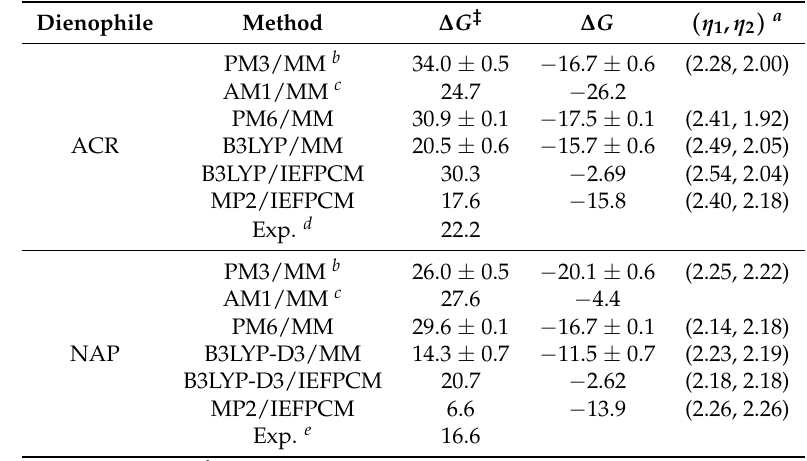
Figure 3. The free energy surfaces under the PM6/MM Hamiltonian ( left ) and under the B3LYP/MM Hamiltonian after Gaussian process regression ( right ) for Diels–Alder reaction between cyclopentadiene and acrylonitrile. Table 1. Activation free energy ∆ G ‡ , reaction free energy ∆ G (in kcal/mol) and the structure of the transition state at 298.15 K for the Diels–Alder reactions between cyclopentadiene and acrylonitrile (ACR), 1-4-naphthoquinone (NAP).